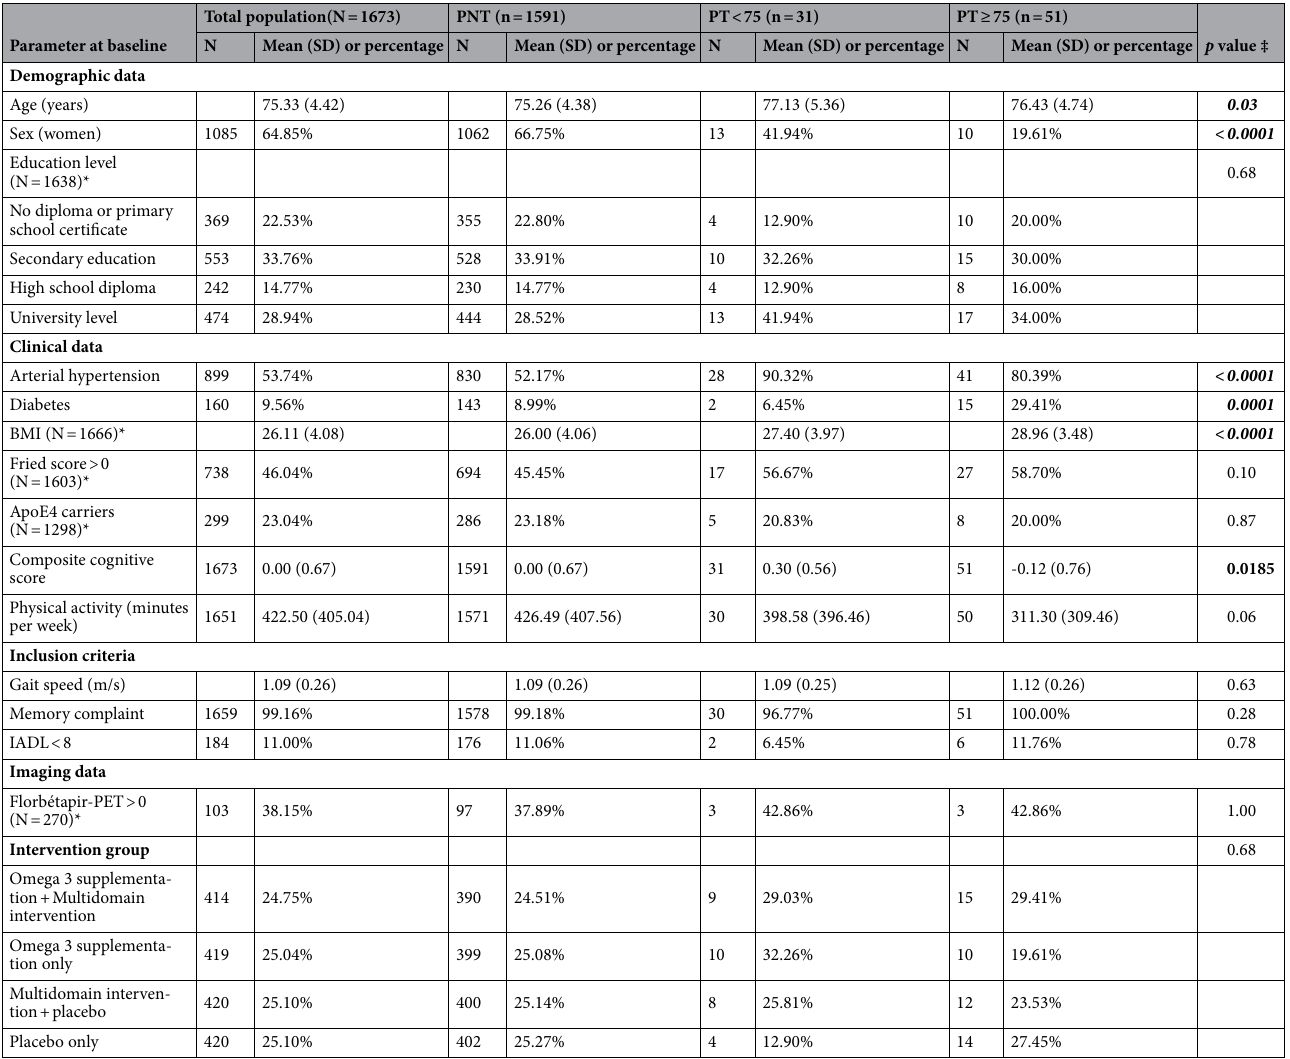
Table 1. Participants’ characteristics at baseline. *Number of subjects with available data. ‡ Statistical tests are comparing the three groups PNT, PT < 75 and PT ≥ 75. ApoE4: apolipoprotein E4; BMI: body mass index; PNT:participants not treated; PT < 75 :participants treated less than 75% of the study follow-up; PT ≥ 75: participants treated more than 75% of the study follow-up; PET positron emission tomography, SD standard deviation. Significative values are written in bold